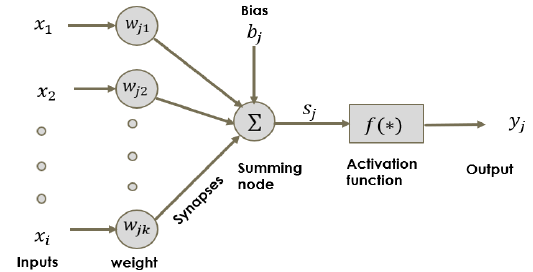
Figure 2. Structure of a neuron.